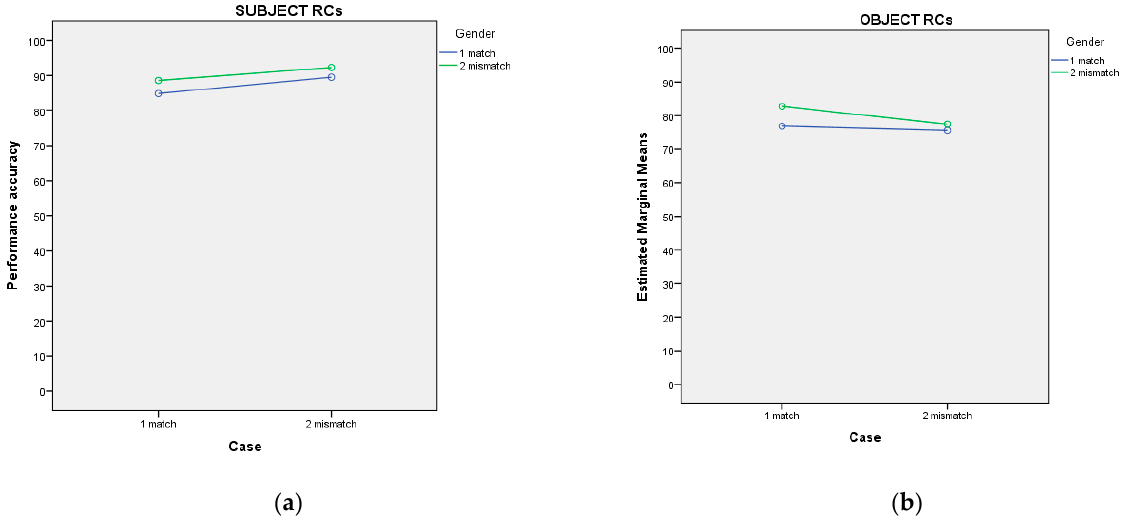
Figure 4. ( a ): performance accuracy on SUBJ RC, case match and mismatch condition, ( b ): perfor- mance accuracy on OBJ RC, case match and mismatch condition.